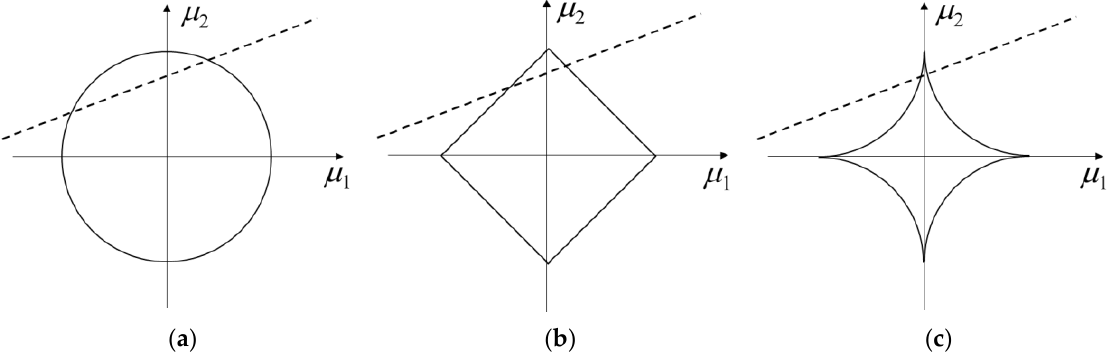
Figure 2. Idea of the regularization minimizing p -norm of the reconstructed image with ( a ) p = 2 (Tikhonov regularization), ( b ) p = 1, and ( c ) 0 < p < 1. The solid lines represent the points of ( μ 1 , μ 2 ) with a constant value of the p -norm. The dashed lines represent the group of points providing identical measurements. The cross-section points of the solid and dashed lines are solutions with a certain value of the p -norm. By minimizing the norms, the tangent points are selected as the optimal reconstructed image.